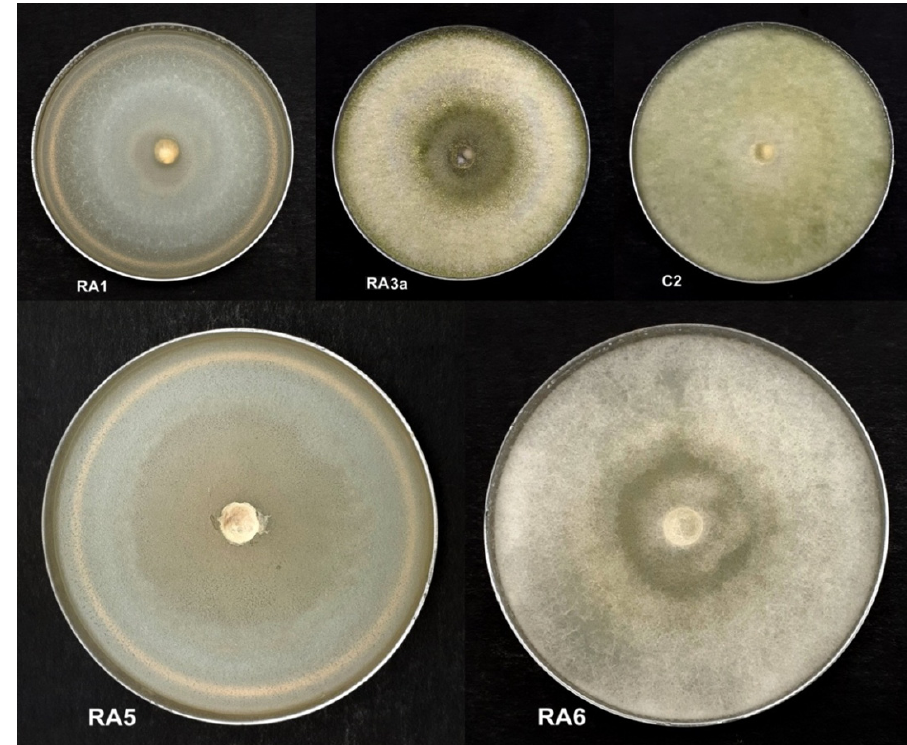
Figure 2. Physical morphology of the five fungal isolates RA1, RA3a, C2, RA5, and RA6 cultured on PDA plates growing filamentous mycelia across the agar after five days of incubation. All isolates show the morphological characteristics of Trichoderma —white filaments and, as the isolates mature, faint olive-green spores. Table 2. Antagonistic potential of the Trichoderma isolates against E. mallotivora. The negative ( − ) control consists of 100 µL of PDB, the positive (+) control of 100 µL of kanamycin (100 µg/mL).